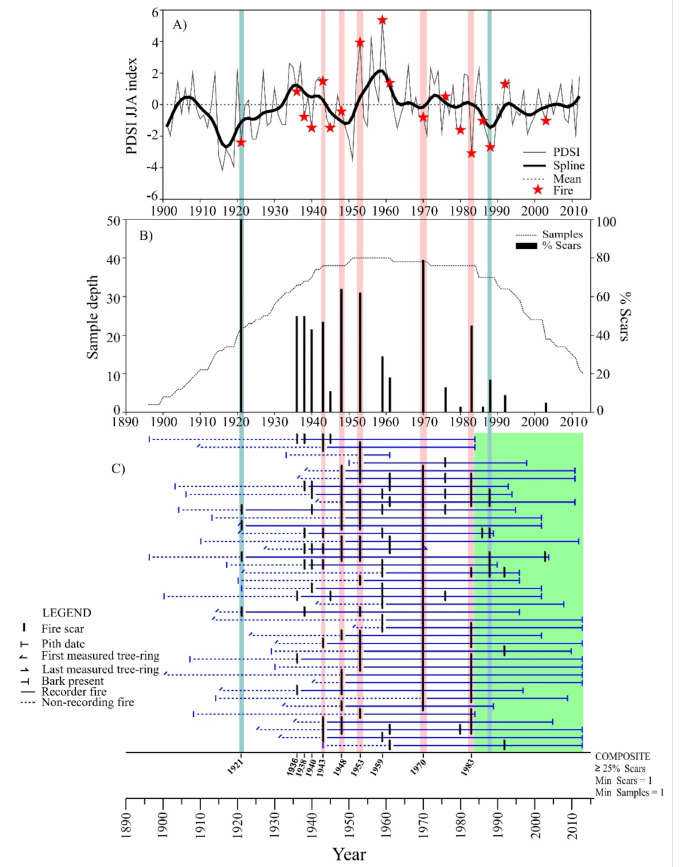
Figure 3. Fire history graph for an Abies religiosa forest in the Sierra Norte de Puebla, Mexico. ( A ) Palmer Drought Severity Index (PDSI) for the last century [46] and ( B ) percentage of fire-scarred trees per year, along with sample depth. ( C ) Timeline for each individual tree (horizontal lines), with vertical dashes indicating recorded fire-scars with fires recorded by ≥ 25% highlighted with dates below the graph. The green shading indicates a period of fire frequencies change after 1983 compared to prior period. The blue and pink bars indicate the drought condition during the most widespread